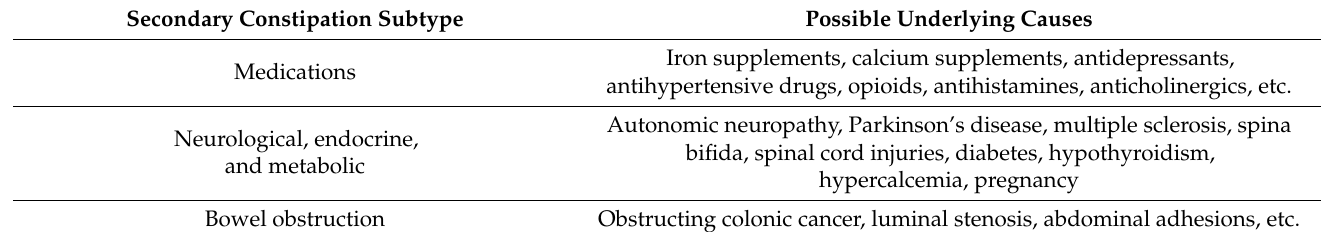
Table 2. Causes of secondary constipation